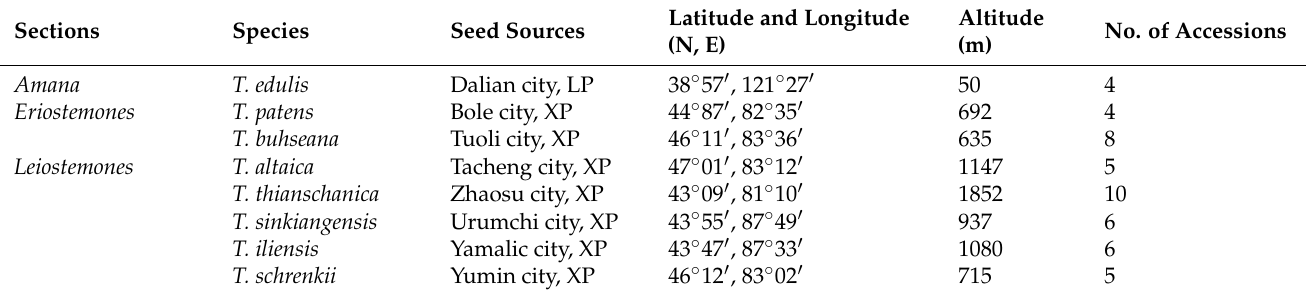
Table 1. Information of the eight wild Tulipa species native to China.